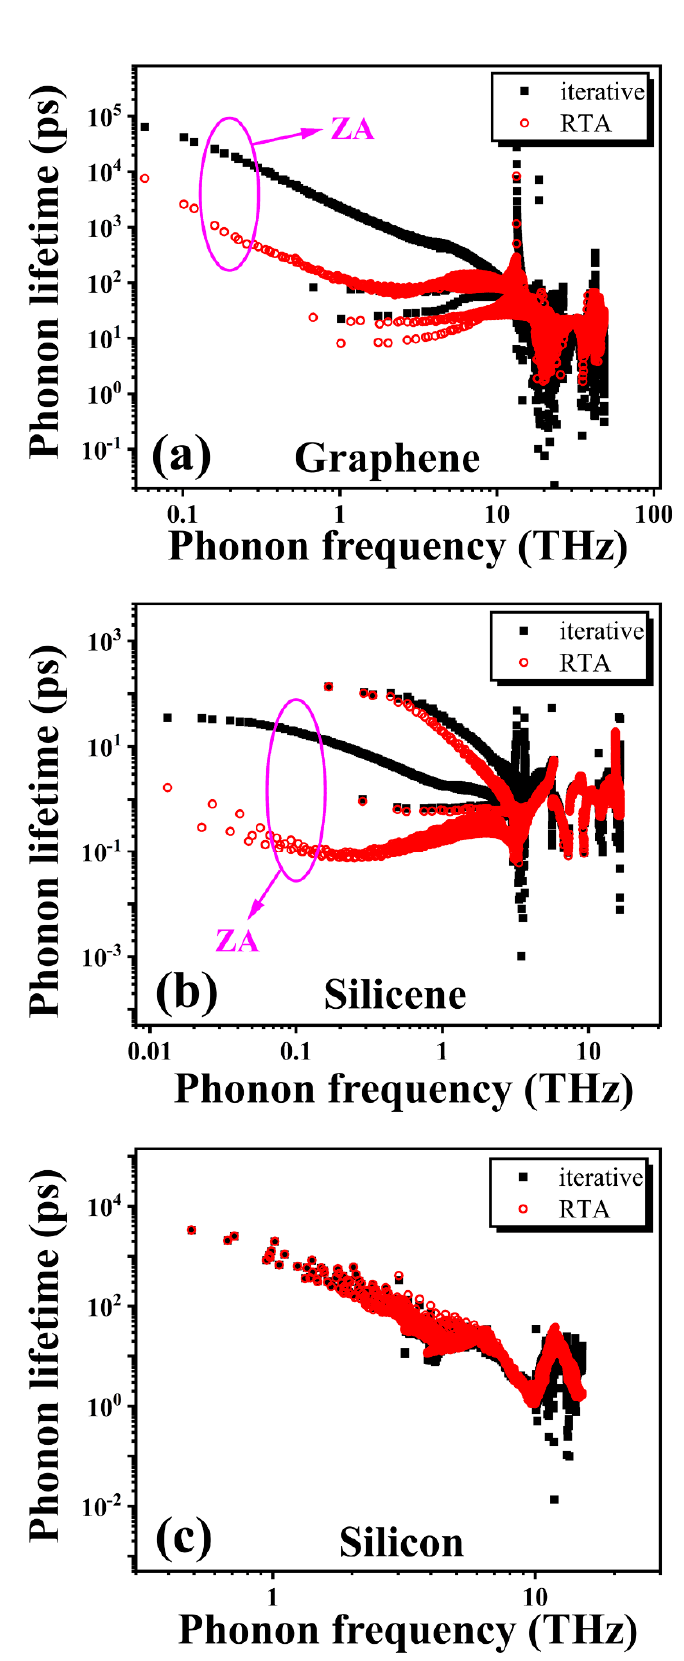
Figure 4. The phonon lifetime calculated from the iterative solution and relaxation time approxima- tion at 300 K in ( a ) graphene, ( b ) silicene, and ( c ) bulk silicon. Huge differences in the phonon lifetime for the low-frequency ZA mode are observed in graphene and silicene.